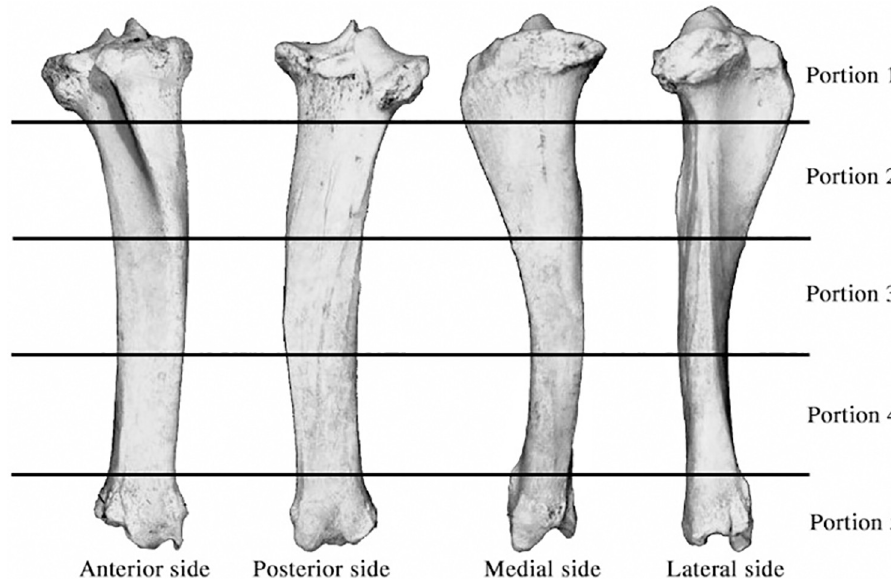
Fig 1. Bone areas by portions and sides. Portion 1 (p1): proximal articular end; Portion 2 (p2): proximal diaphysis; Portion 3 (p3): medial diaphysis; Portion 4 (p4): distal diaphysis; Portion 5 (p5): distal articular end and Anterior (a), Posterior (p), Medial (m) and Lateral (l) side (adapted from [62];